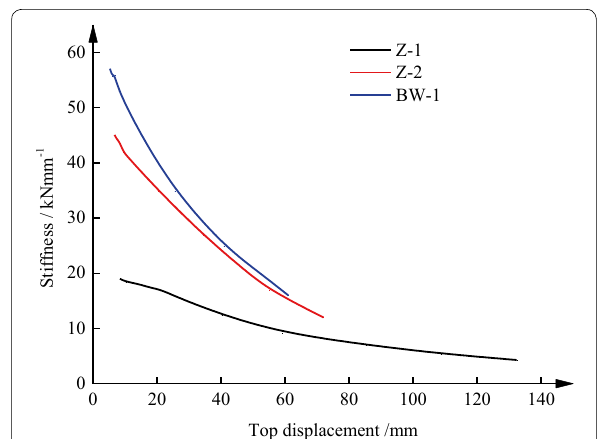
Fig. 9 Stiffness degradation curves of three specimens.